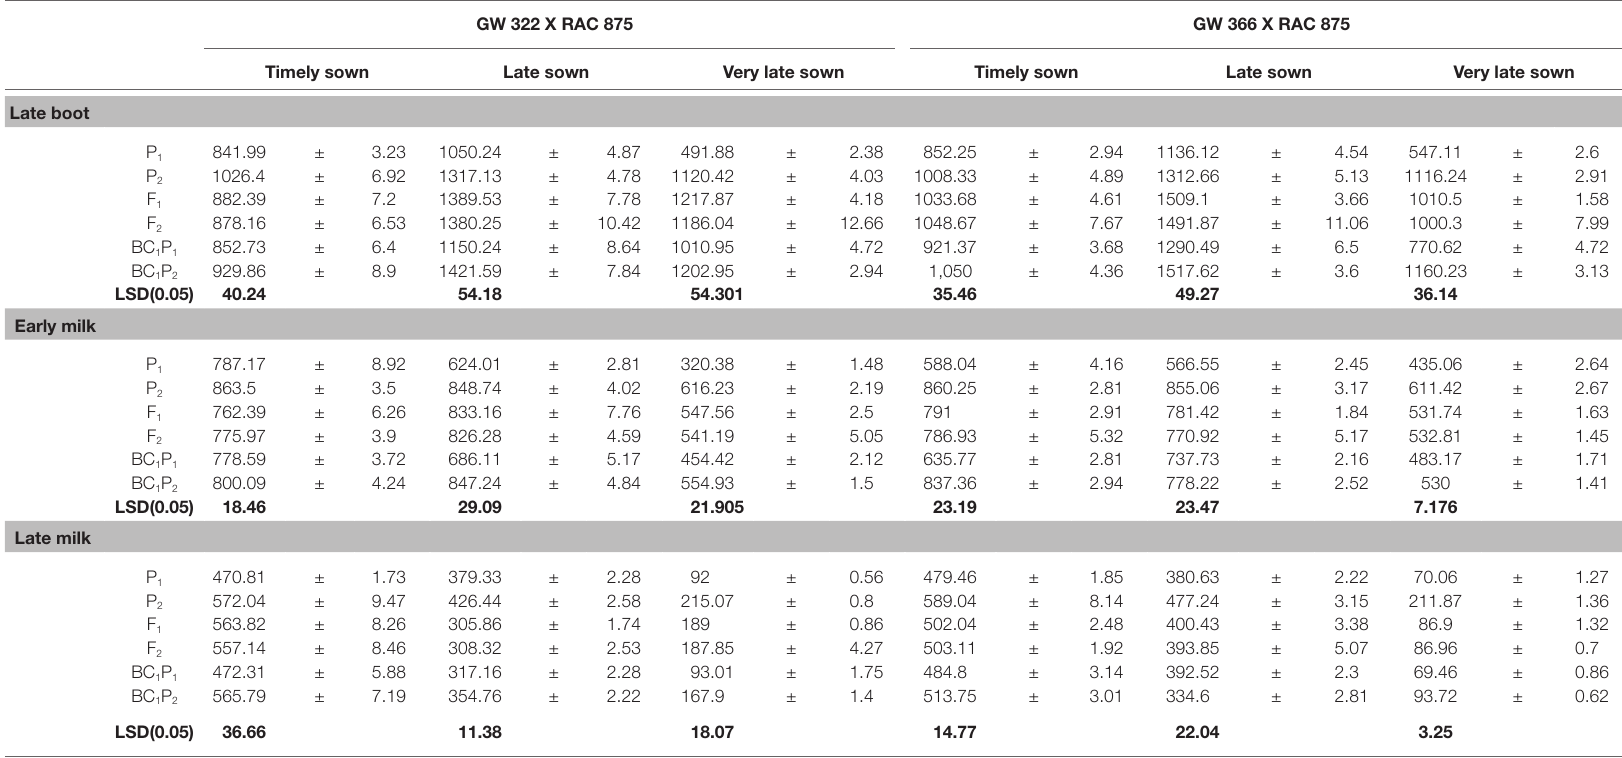
TABLE 3 | Mean stomatal conductance mmolm −2 s −1 with their standard error measured on parental, F 1, and segregating generations for two crosses GW 322 X RAC 875 and GW 366 X RAC 875 under timely, late, and very late sown condition.